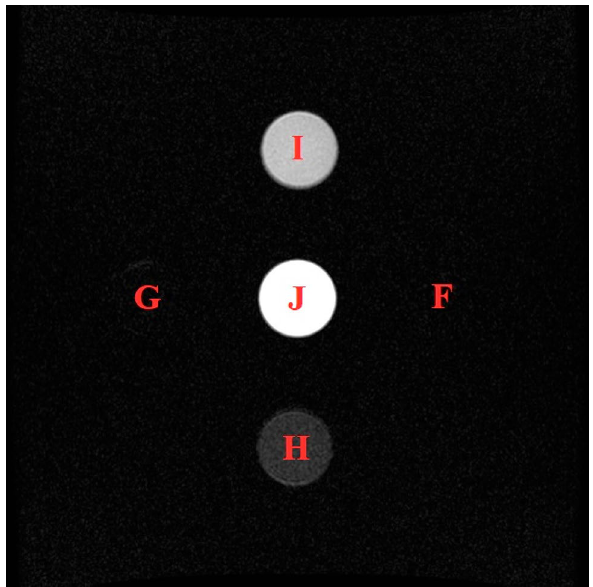
Figure 3. Magnetic resonance imaging evaluation (SSFSE TE: 1200 ms; TR 4000 ms) of five pineapple juices at different